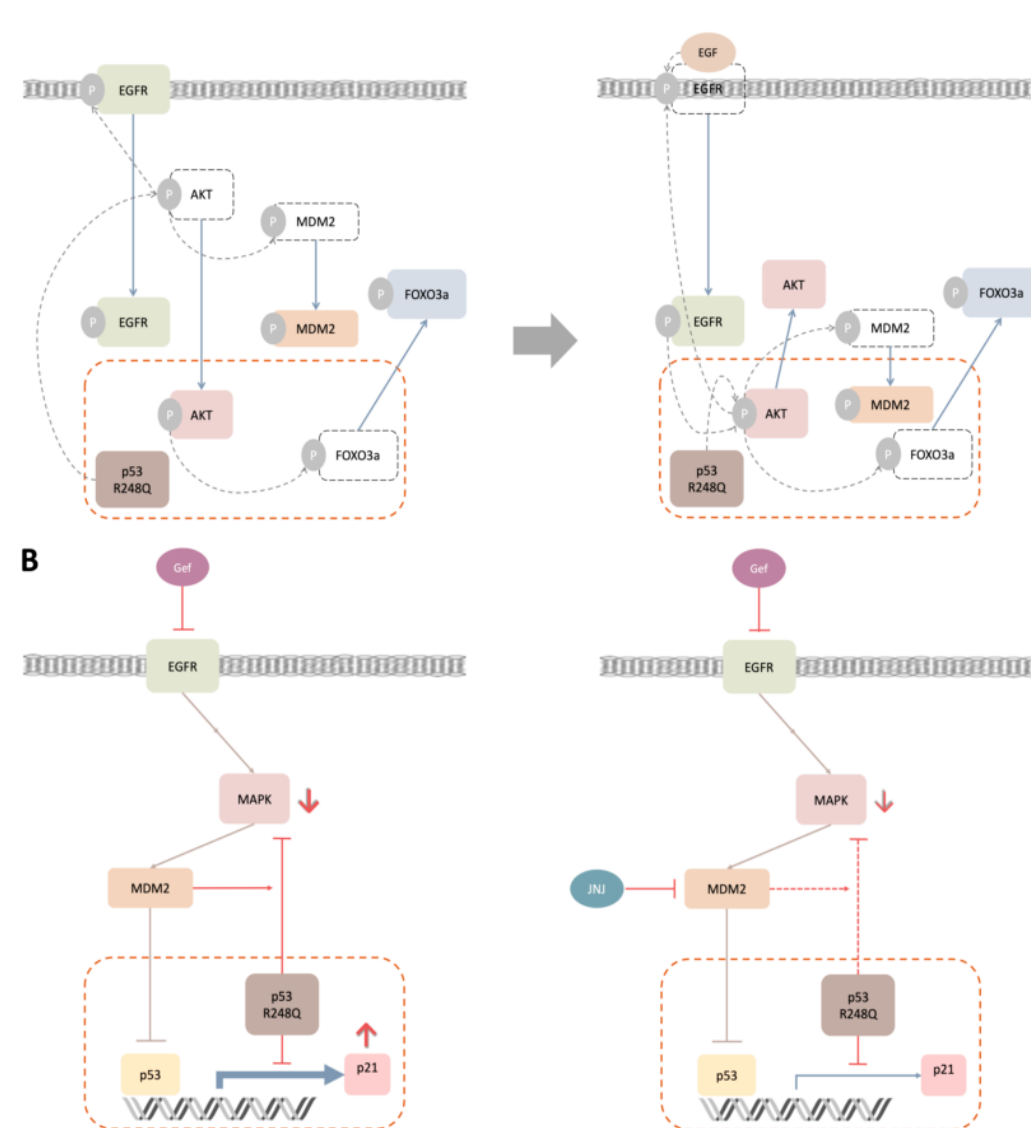
Figure 7. Hypothetical models to integrate molecular trafficking and synergistic lethal effects of gefitinib and JNJ with p53 R248Q overexpression. ( A ) This model scheme depicted the signal transduction and molecular trafficking under p53 R248Q overexpression and/or EGF stimulation in OVCAR3 cells. ( B ) This model scheme depicted the molecular regulation under gefitinib and/or JNJ treatments in OVCAR3 cells with p53 R248Q